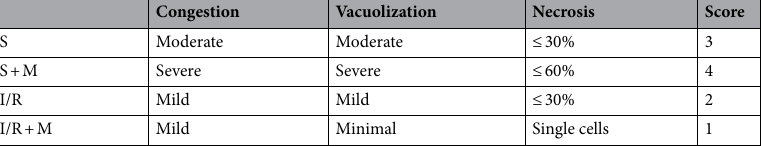
Table 6. Liver Suzuki histological score (0–4) based on the sinusoidal congestion, vacuolization of hepatocyte cytoplasm, and parenchymal necrosis. Experimental group abbreviations: S sham-operated rat group, S + M sham-operated + meldonium rat group, I/R ischemia/reperfusion rat group, I/R + M ischemia/ reperfusion + meldonium rat group.